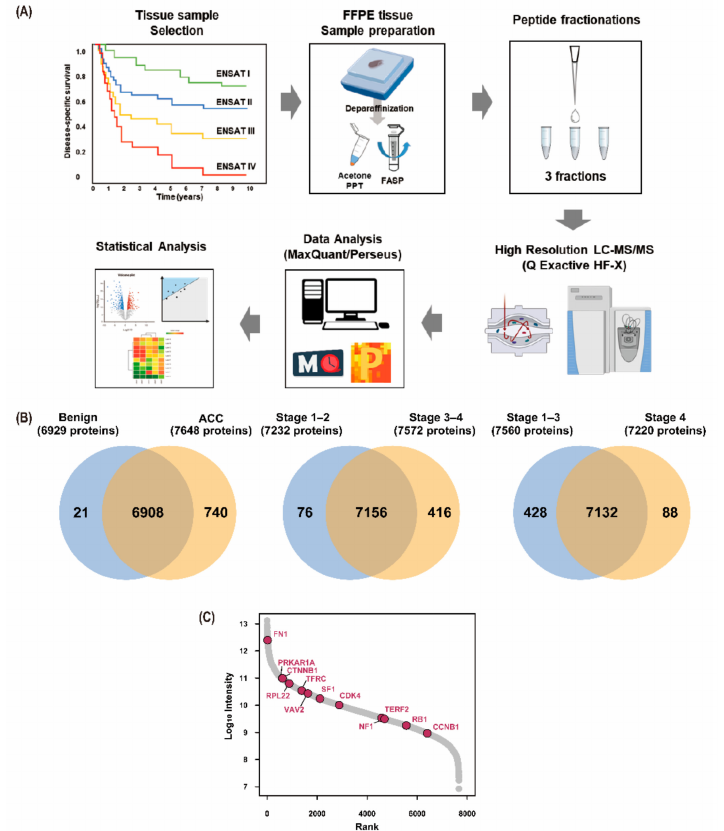
Figure 1. Overall workflow and results of proteomic analysis. ( A ) Overall workflow for proteomic analysis of adrenal cortical carcinoma FFPE tissues with respect to ENSAT staging is